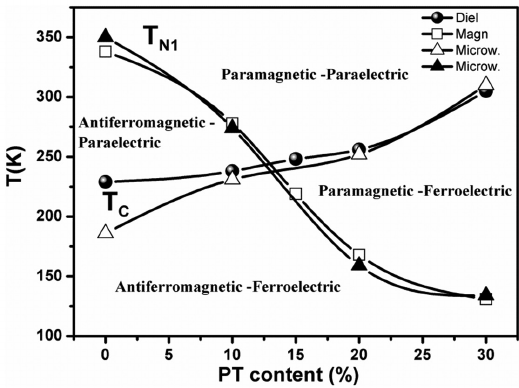
Figure 6. Transition temperatures for ferroelectric and antiferromagnetic ordering in (1-x) Pb (Fe samples, with x = 0.0, 0.05, 0.10, 0.15, 0.17, 0.20 and 0.30 depending on the concentration of PT (x), measured by different techniques: dielectric impedance spectroscopy, magnetic susceptibility and dielectric microwave impedance